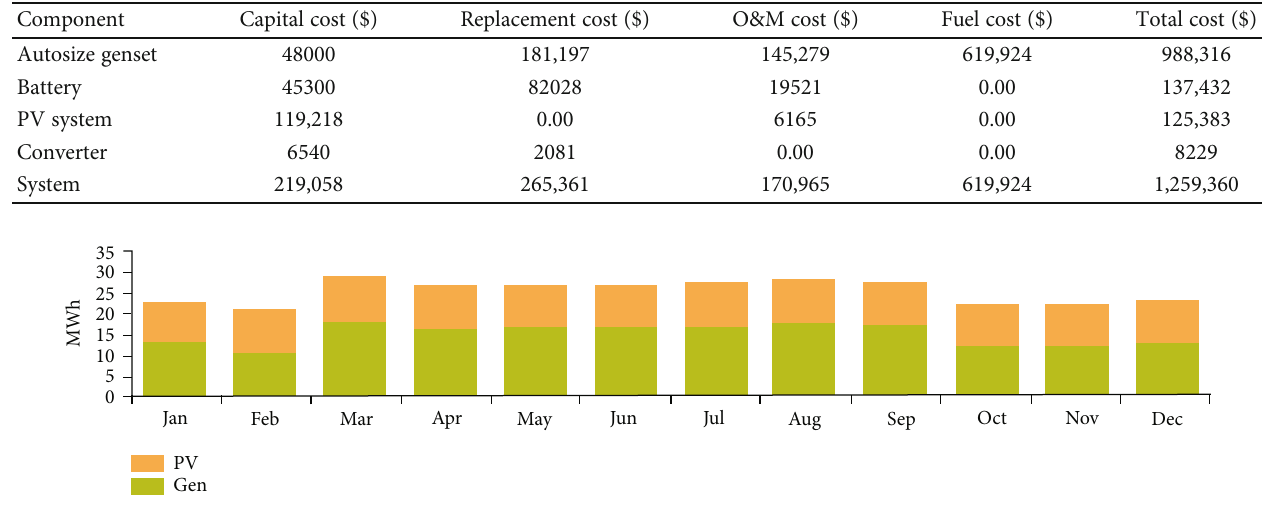
Figure 12: Monthly average electricity production of the hybrid PV/diesel system with battery for the full-option